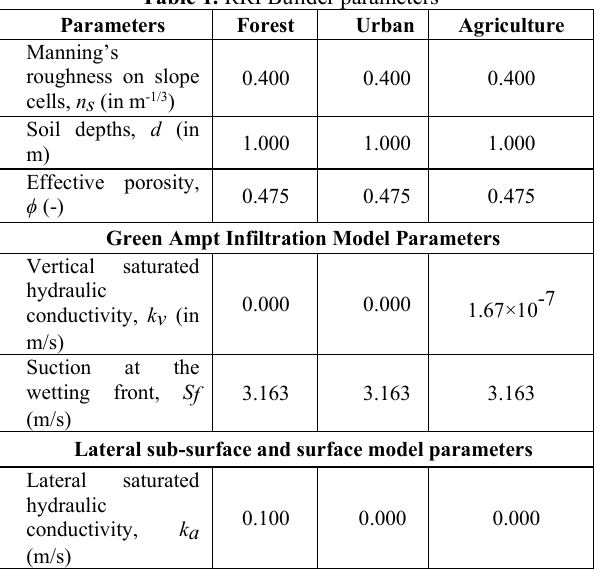
Table 1. RRI Builder parameters